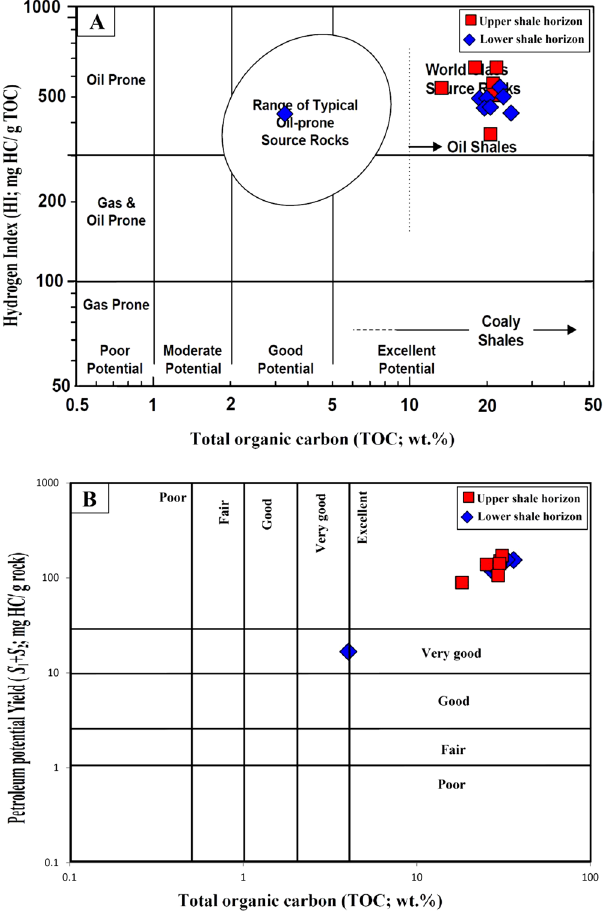
Figure 12. Geochemical correlations between TOC content and Rock–Eval data, ( A ) plot of TOC vs. HI and ( B ) plot of TOC vs. PY(S1 + S2). It implies that the shale horizons of the Palana Formation in the Bikaner sub- basin are oil-shale resources and should generate significant amounts of oil in the sufficient thermal